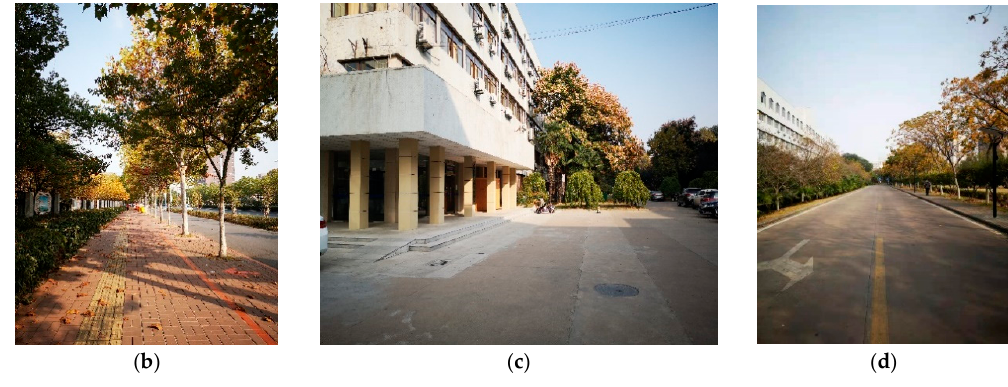
Figure 11. ( a ) Satellite map and ( b – d ) photographs of outdoor positioning area.